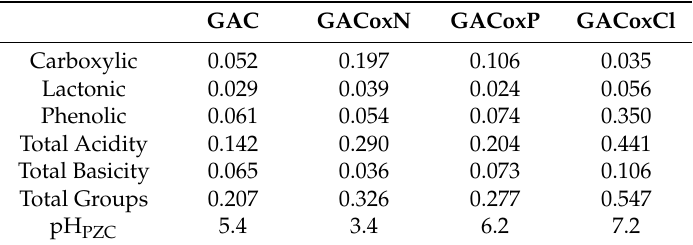
Table 3. Density of surface functional groups (molecules nm − 2 ) determined by Boehm titration and point of zero